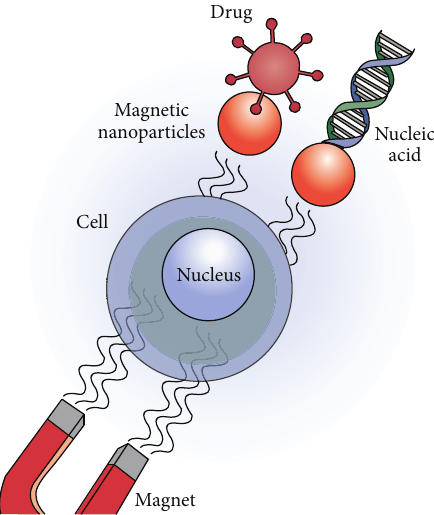
Figure 18: The schematic of magnetic targeted drug delivery mechanism